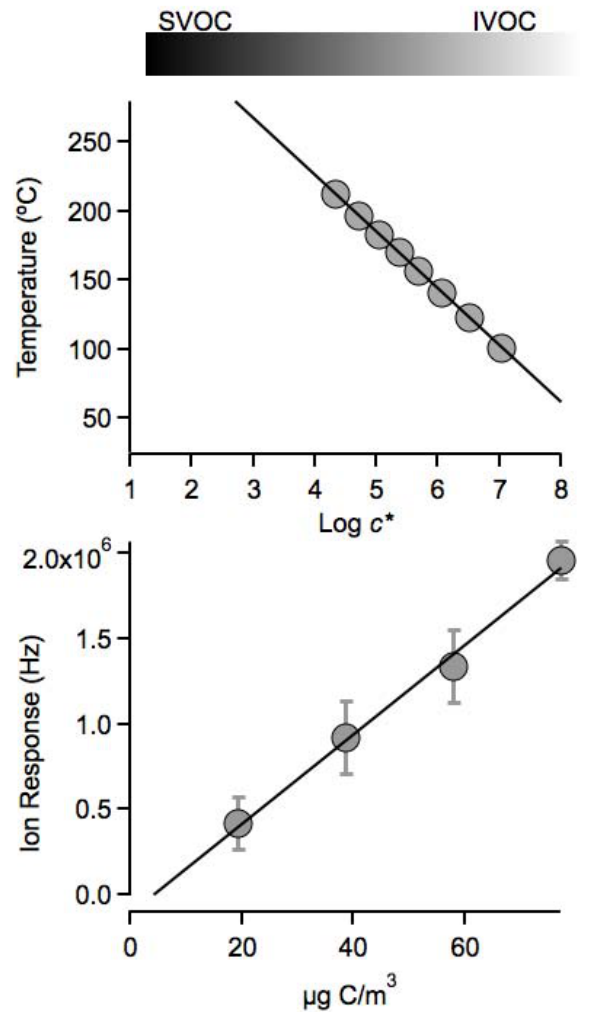
Fig. 2. Laboratory calibration results for the I/SVOC instrument, using syringe injections of known straight-chain n -alkanes. Top panel: empirical relationship between desorption temperature and saturation vapor concentrations of C 13 –C 20 alkanes. A robust field- based calibration for the c ∗ – T relationship was not obtained during AAFEX-II. Therefore, we define the general volatility bounds of the IVOC and SVOC species with the grey-scale bar shown along the top of the figure. Bottom panel: total mass spectrometric signal for different mass concentrations of injected straight-chain C 8 –C 20 n -alkane standard, demonstrating the linearity and sensitivity of the instrument.